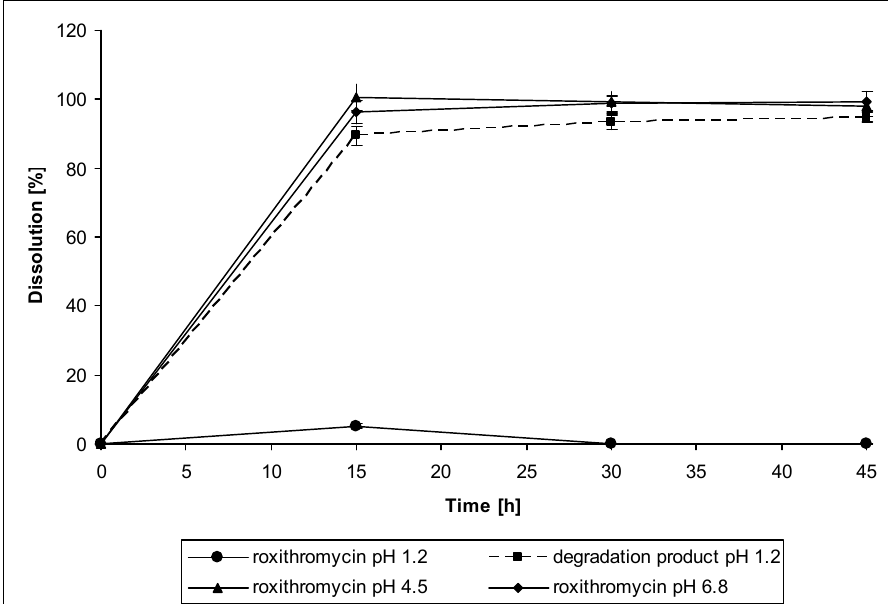
Figure 5. Dissolution of roxithromycin and its degradation product from suspension at pH 1.2, 4.5, and